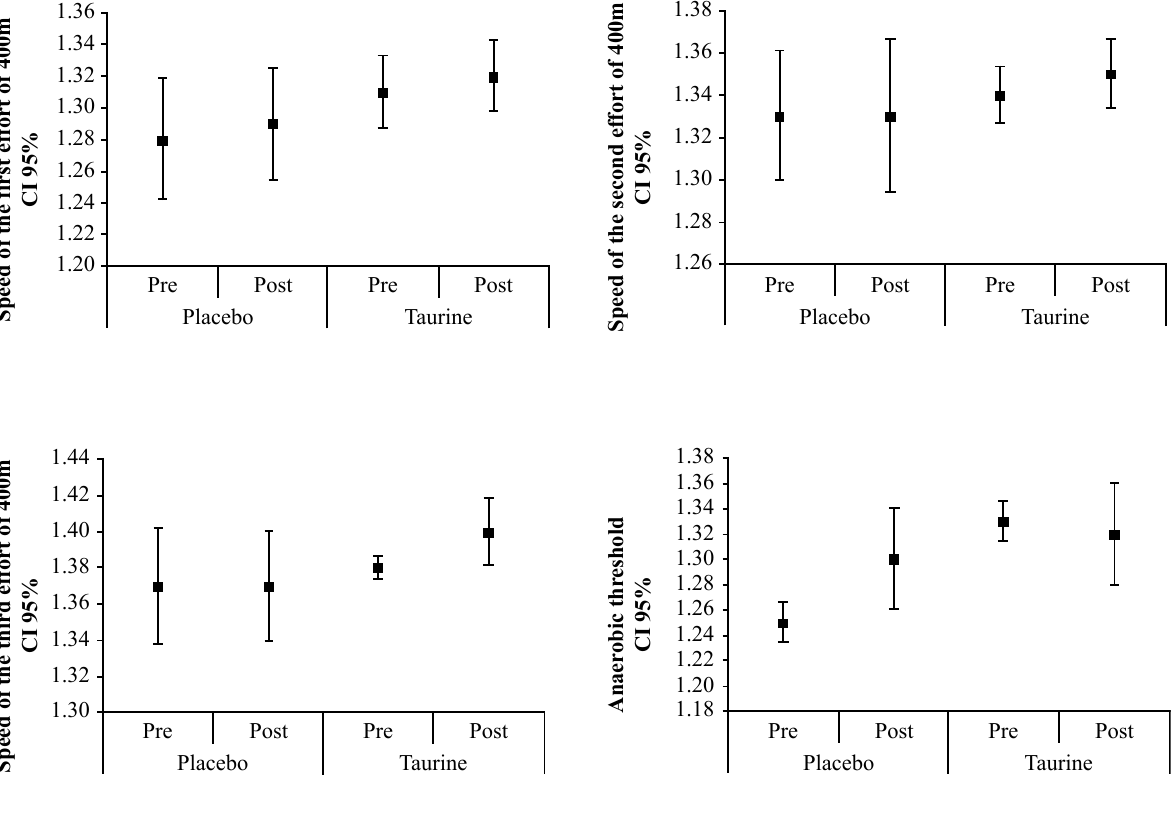
Figure 4. Evaluation of mean speeds (m/s) before (Pre) and after (Post) 8 weeks of placebo or taurine supplementation (n =